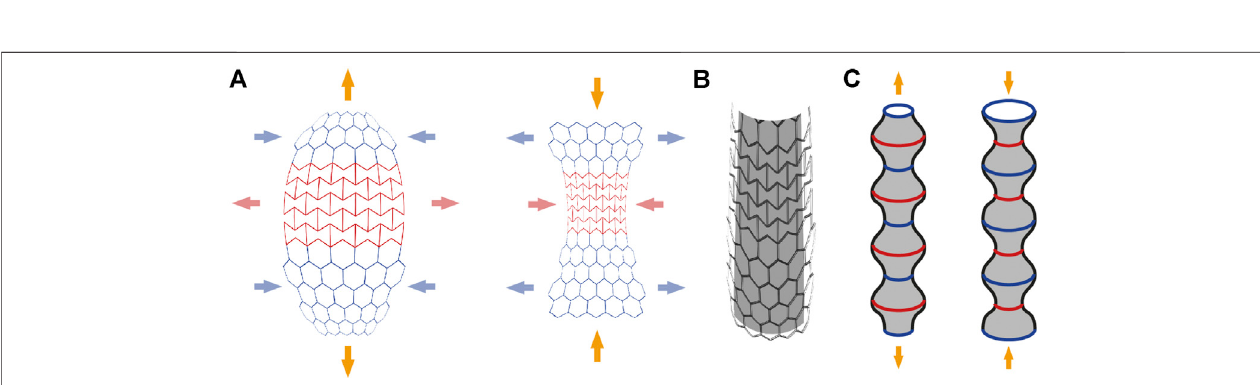
FIGURE 9 | Shape-change foundation based on auxetic behavior — The combination of auxetic and non-auxetic structures in a plane produces edge curvature whencompressedorstretchedassimpli fi edin (A) .Whenthiscombinedstructureislongitudinallystretched(i.e.,yellowarrows),theauxeticsection(i.e.,inred)stretches whilethenon-auxeticone(i.e.,inblue)shortens (A-left) .Thereversebehaviorhappenswhenthecombinedstructureiscompressedlongitudinally (A-right) .Whenrolled into a cylinder (B) , the longitudinal compression or stretching produces horizontal wrinkles (C) . This cylinder can serve as a vertical foundation pile to resist compression and tensile